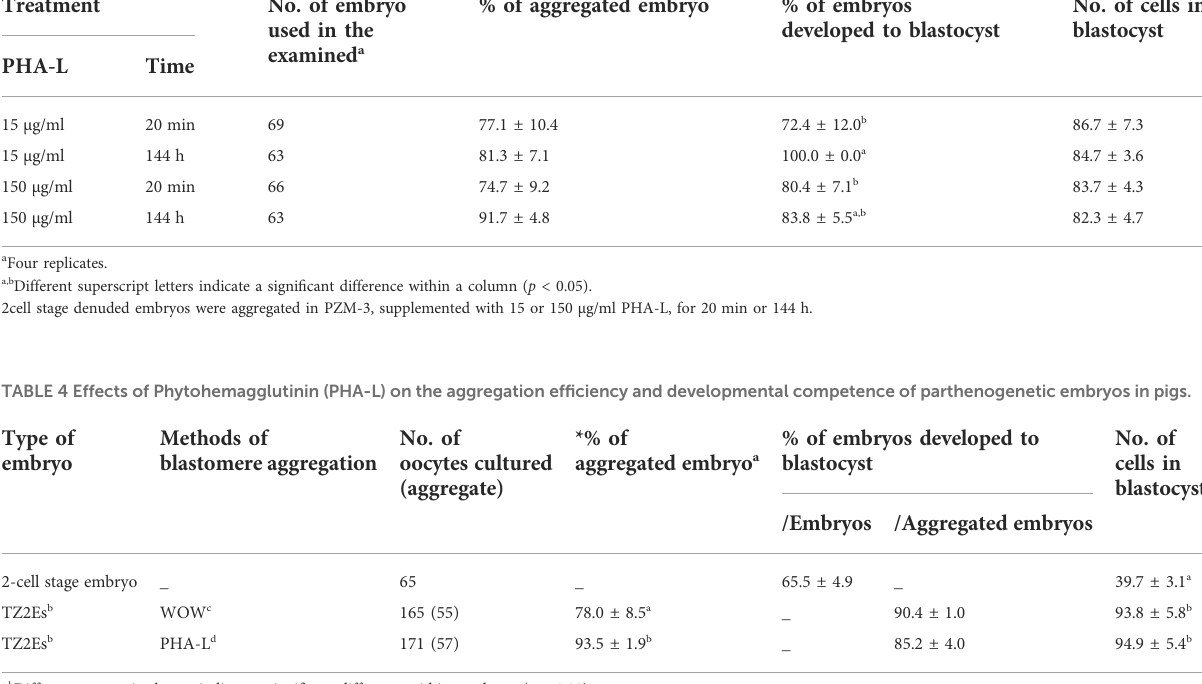
TABLE 3 Effects of culture time with Phytohemagglutinin (PHA-L) and developmental competence of parthenogenetic embryos in pigs. Treatment